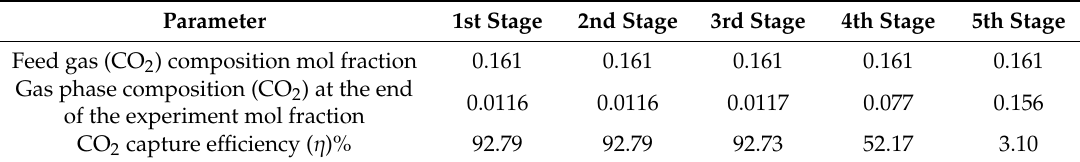
Table 2. CO 2 composition at the start of the experiment (feed gas) and at the end of the experiment analyzed by gas chromatography from a gas mixture of 16% CO 2 and rest N 2 along with calculated CO 2 capture e ffi ciency ( η